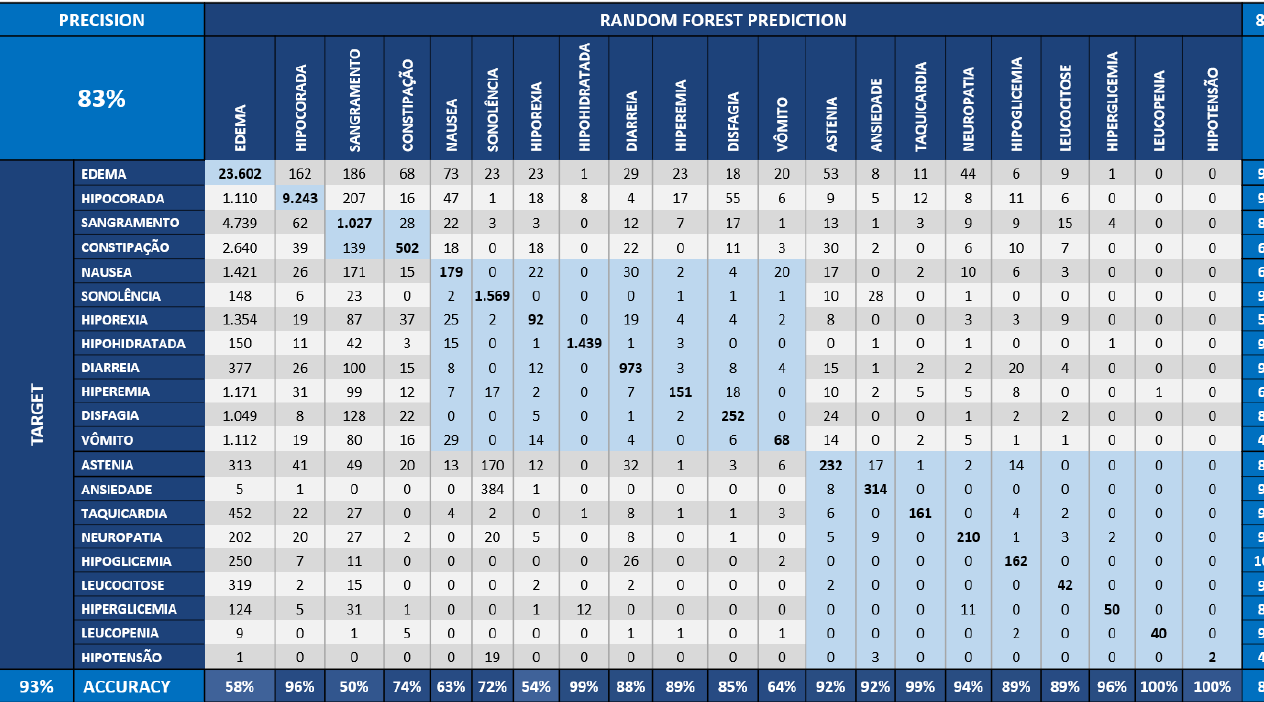
Figure 13. Benchmark 1—Base